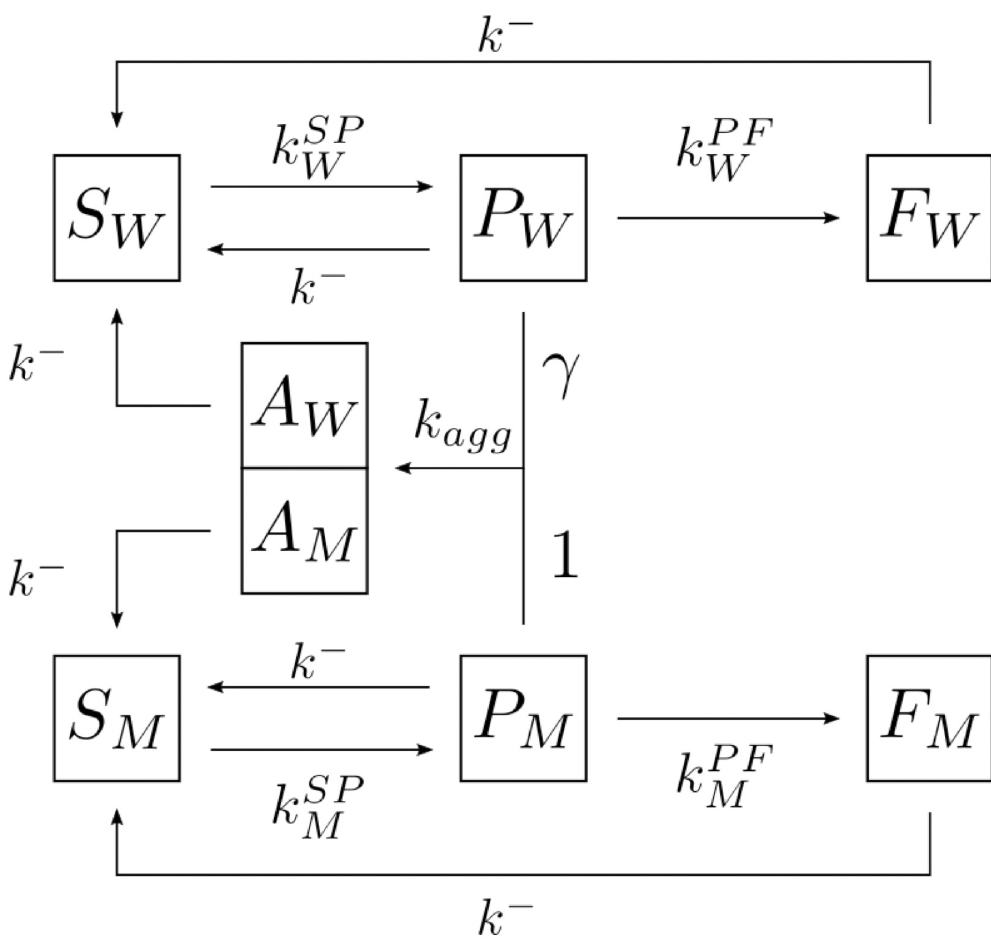
Fig 1. Graphical diagram of the proposed reaction